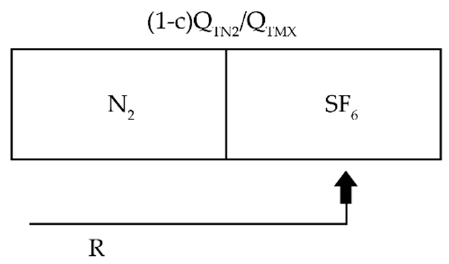
Figure 4. The type of molecule decision scheme.